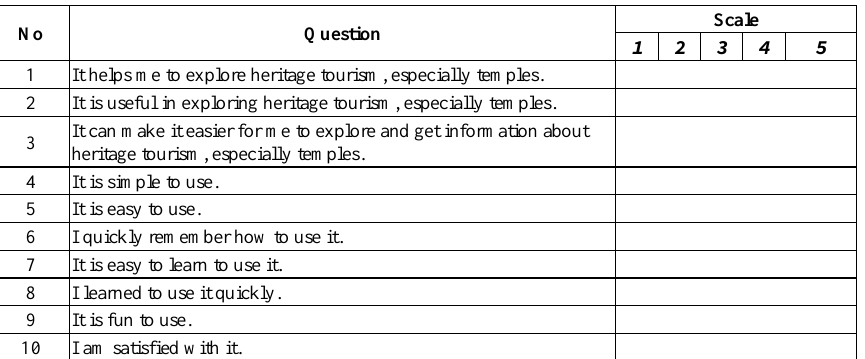
Table 2. Questionnaire [7].